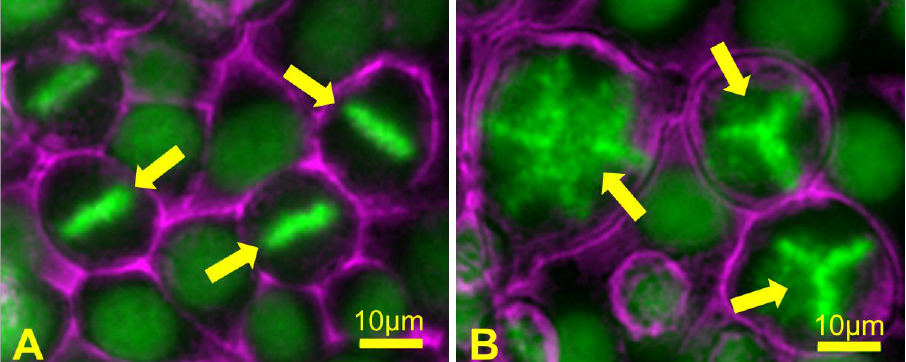
Figure 8. Failed cytokinesis can lead to multipolar spindle formation in the subsequent mitosis. ( A ) A field of control HeLa cells containing mitotic cells showing normal chromosome alignment at metaphase (arrows). ( B ) HeLa cells were treated for a short time with an actin polymerization inhibitor drug, which blocks cytokinesis and results in the formation of binucleate polyploid cells containing extra centrosomes. During the subsequent mitosis, polyploid cells form abnormal metaphase chromosome alignments (arrows) when the presence of extra centrosomes leads to assembly of multipolar mitotic spindles. When these cells then undergo anaphase and cytokinesis, chromosomes are segregated in a random, unequal manner, leading to the formation of daughter cells that are highly aneuploid. Chromosomes are depicted in green; cell surfaces are depicted in magenta.